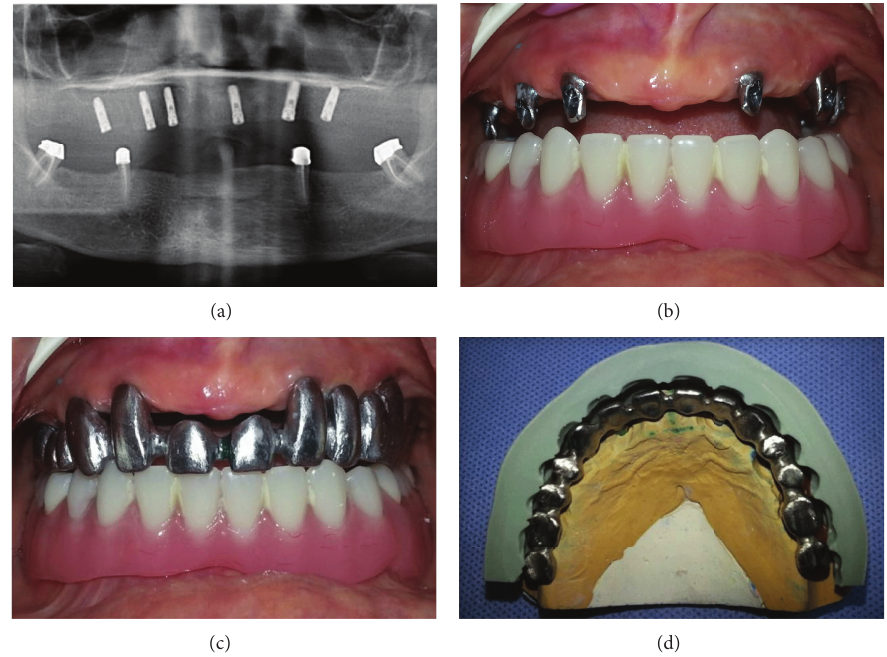
Figure 4: (a) Orthopantomographic view of the case with dental implants. Intraoral view of implant abutments (b) and titanium framework (c). (d) The image of titanium framework with silicone index on the stone model.